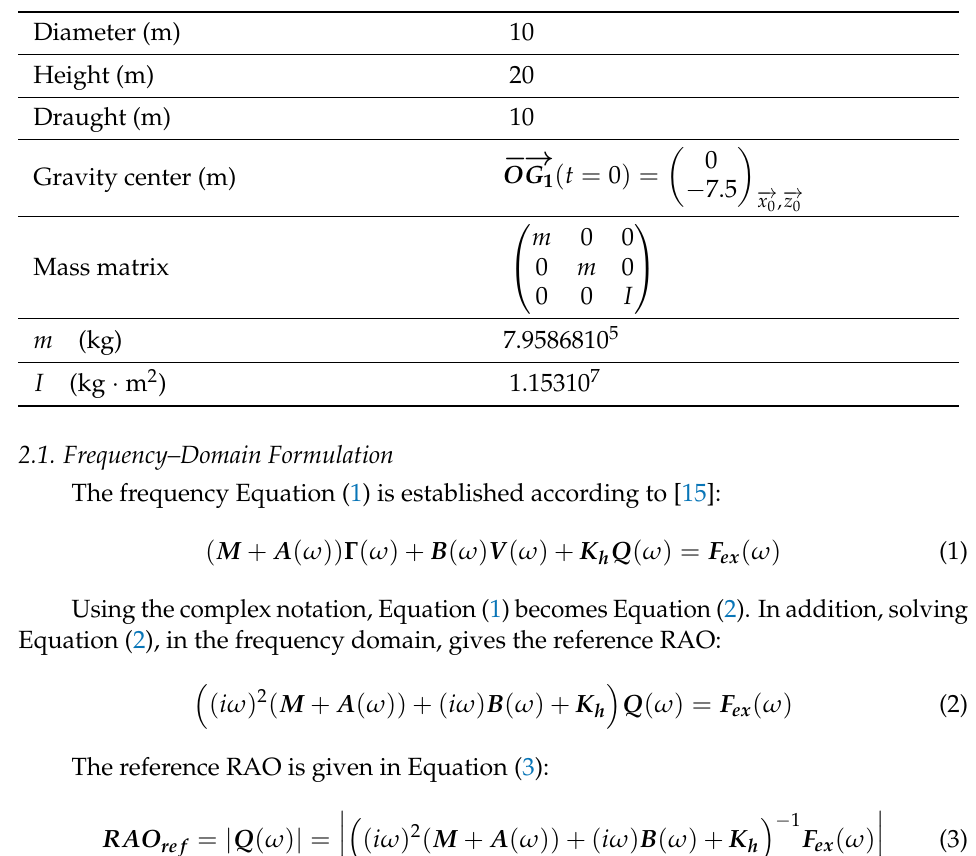
Table 1. Numerical cylinder